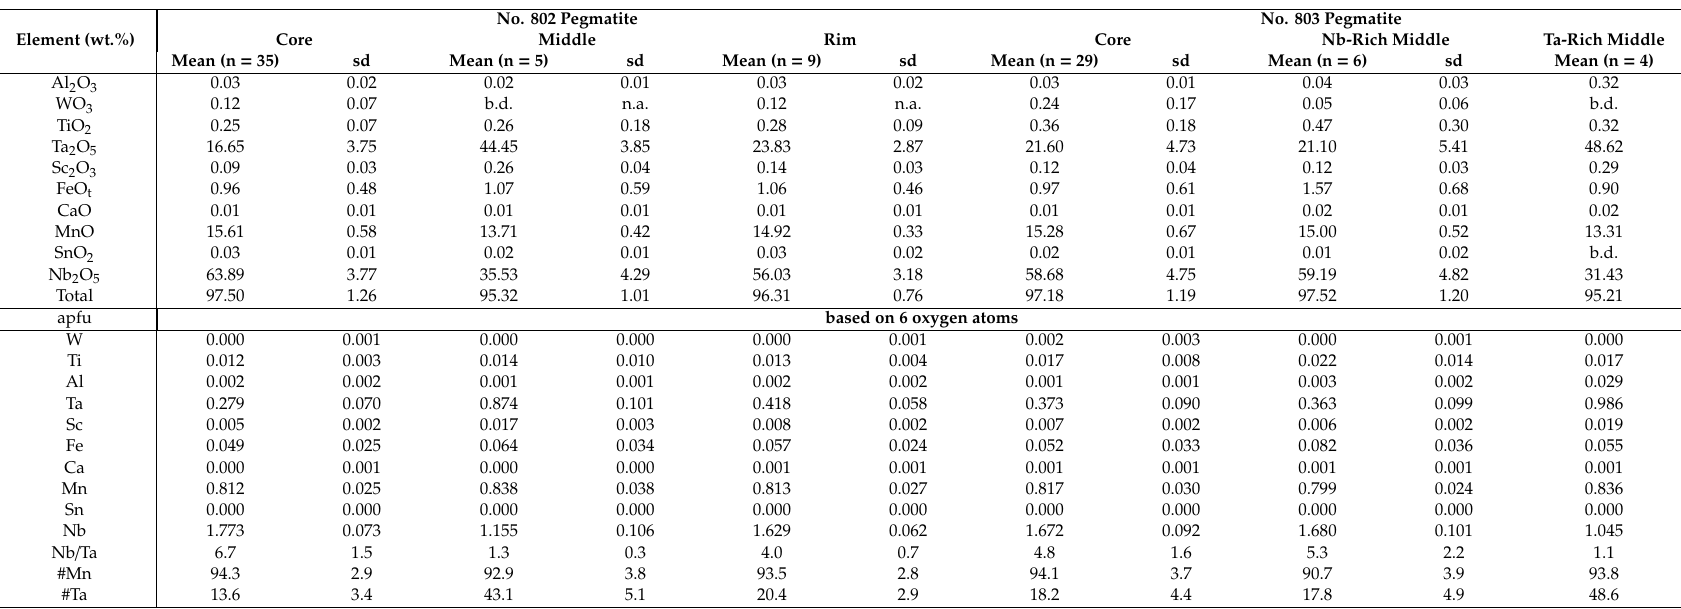
Table 2. Summary of chemical compositions of columbite-tantalite group minerals (CGMs) from the Li pegmatites at Kalu’an. Element